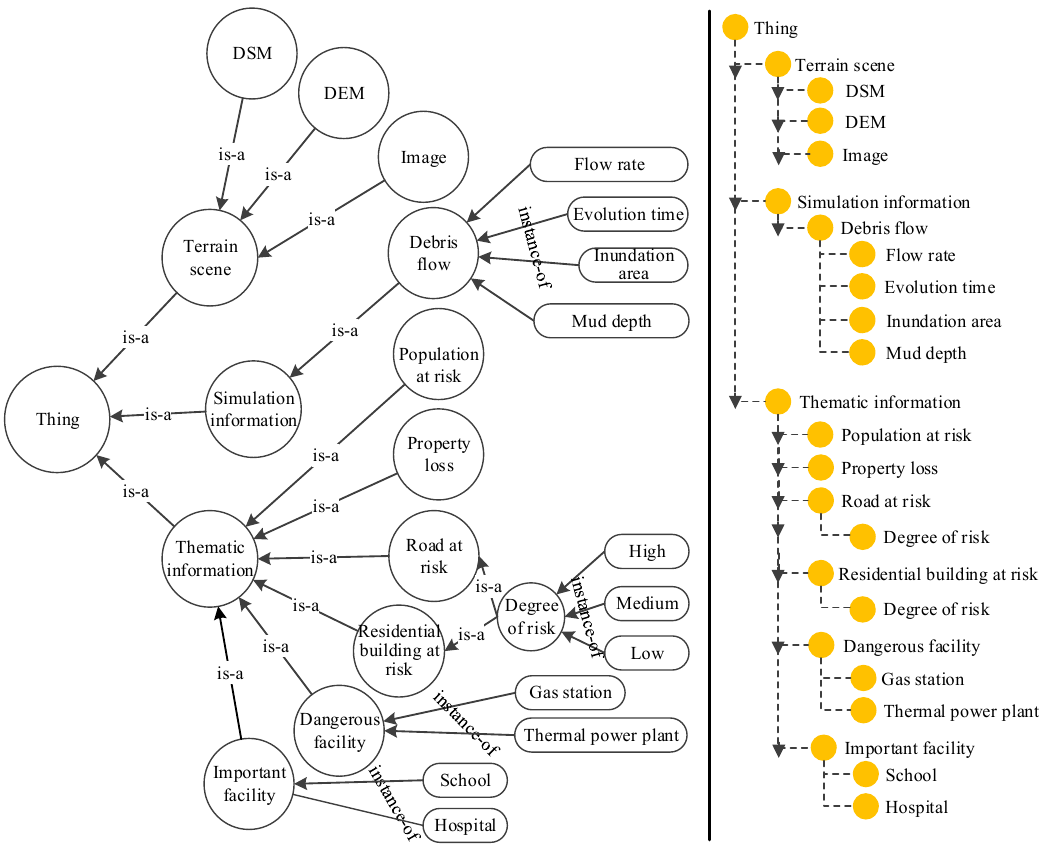
Figure 1. Concept hierarchy of the geographical ontology in a debris flow disaster scene.